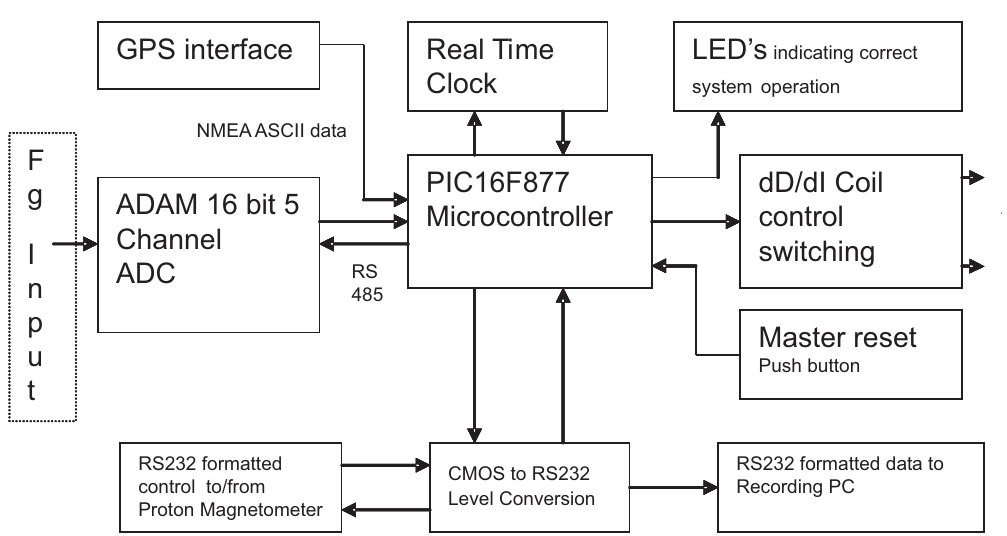
Fig. 3. Controller Block